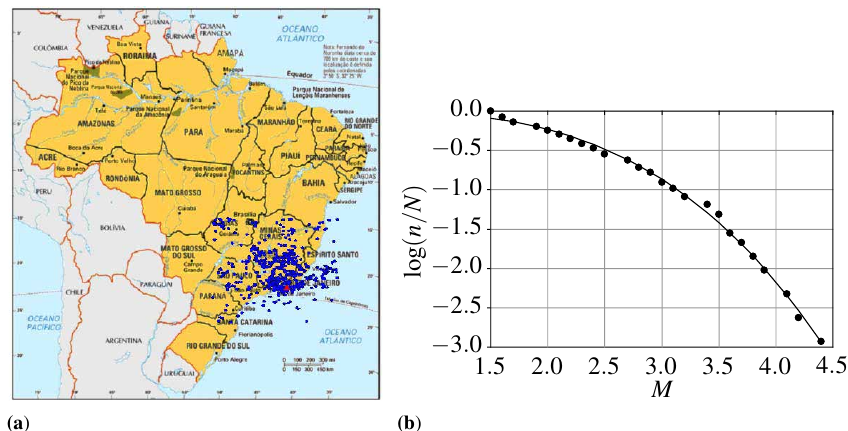
Figure 17. ( a ) Distribution of epicenters of seismic events with M w within a 1200km 2 area in South-Eastern Brazilian Stable Continental Regions (SCR). The red point shows the site of the Angra dos Reis NPP (CNAAA). ( b ) Relation between log ( n / N ) for the region during the same period [47].